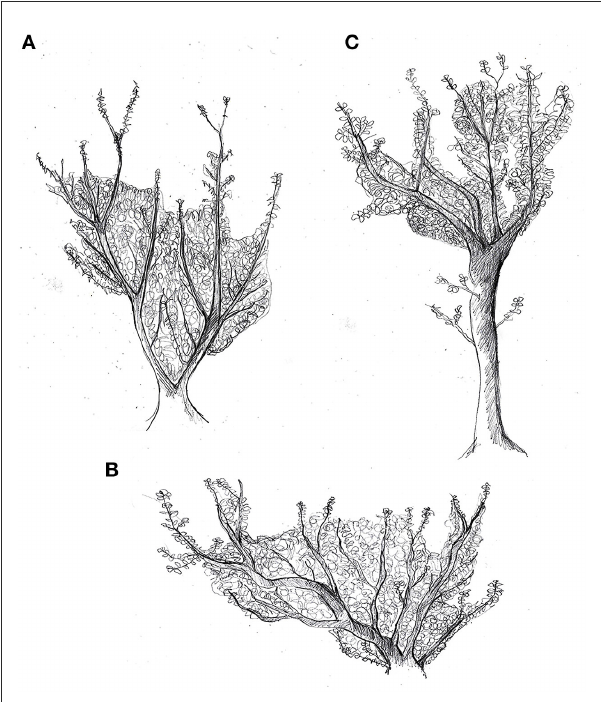
FIGURE3 Tree habitat: illustration of the fifth criterion of the NR classification: (A) low bifurcation, (B) shrub shape, and (C) tree shape (Credit of the